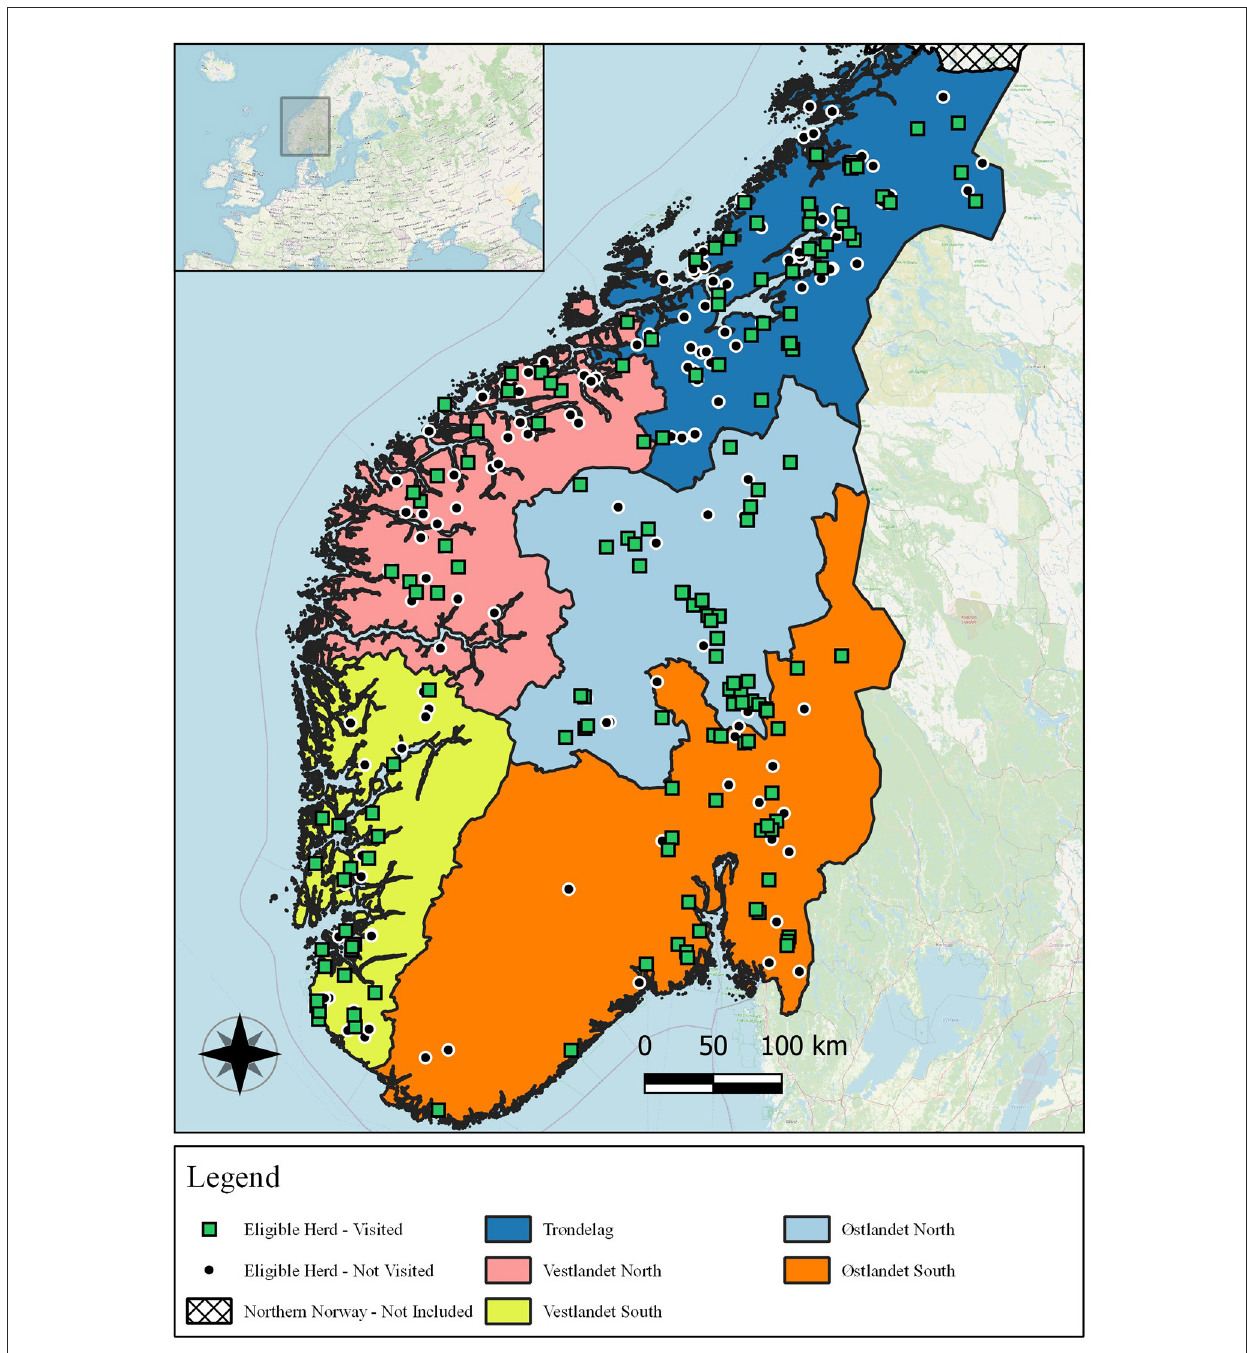
FIGURE2 Map of central and southern Norway showing the five regions investigated, the eligible herds which were visited, and the eligible herds which were not visited.